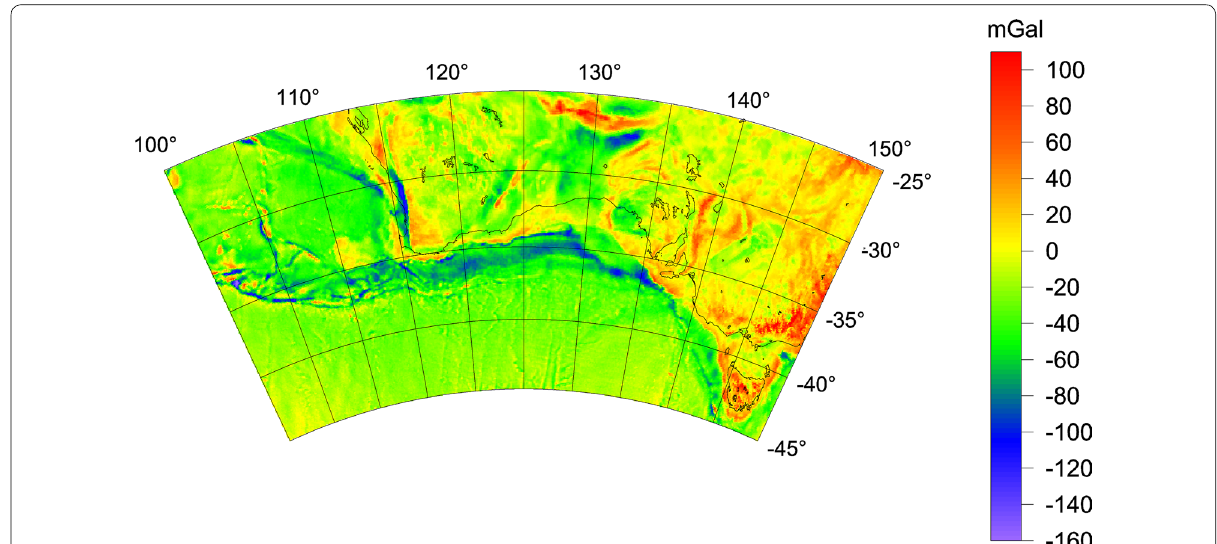
Fig. 14 Δ g [mGal] for the southern Australia computed using the EIGEN 6C4